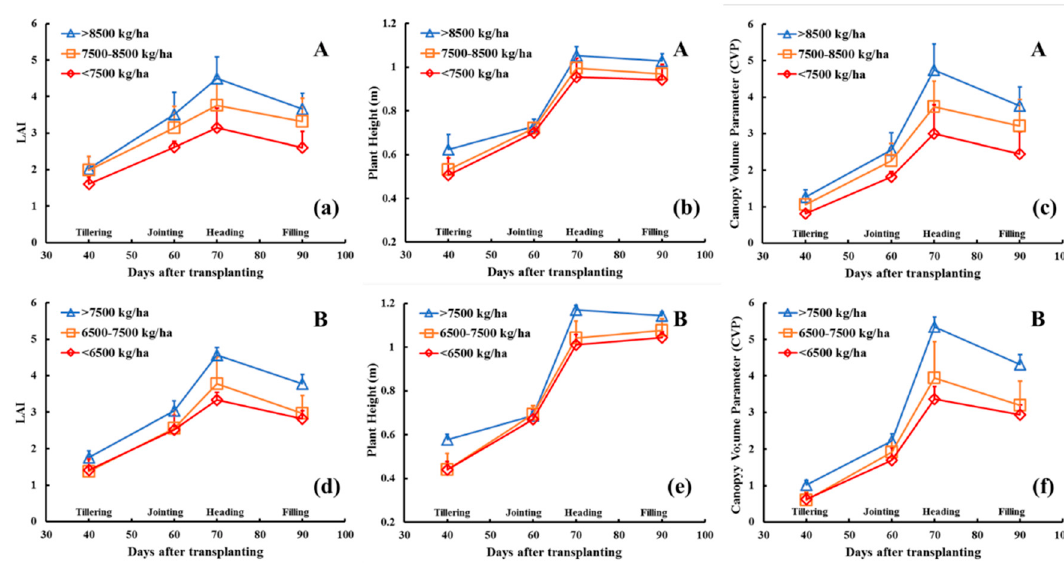
Figure 4. Dynamic changes in rice canopy parameters at different yield levels: ( a – c ) LAI, PH and CVP dynamic changes of the A varieties, ( d – f ) LAI, PH and CVP dynamic changes of the B varieties.